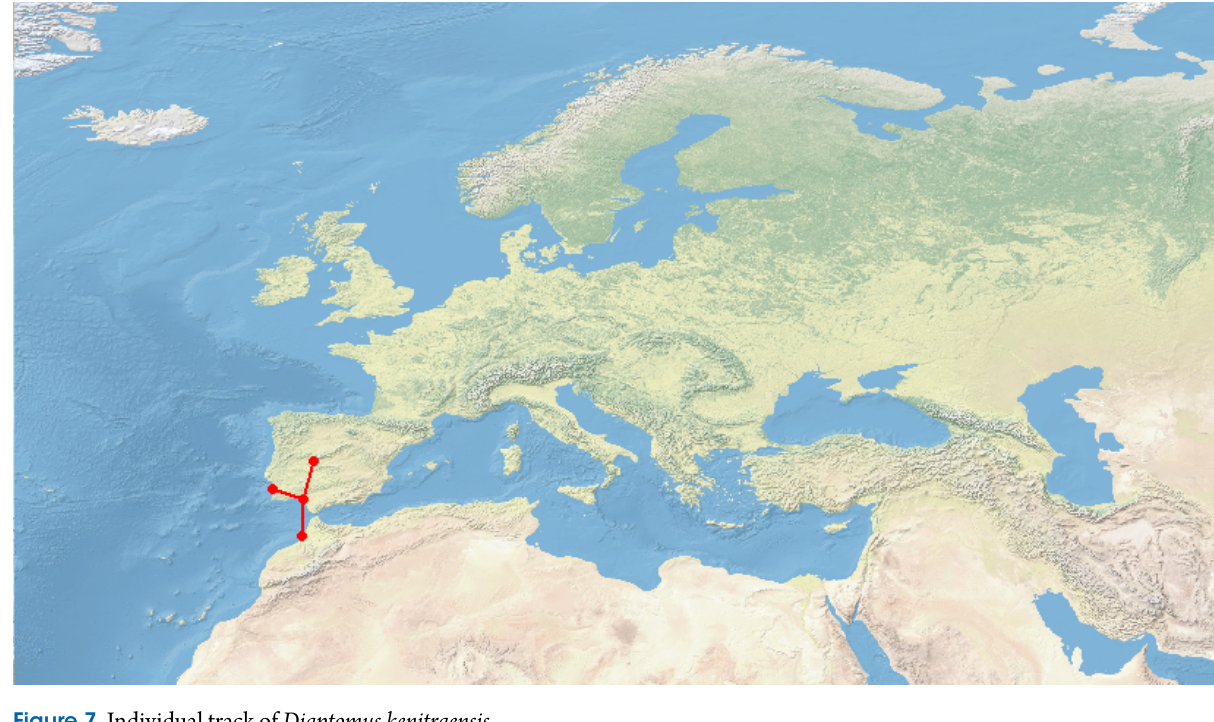
Figure 7. Individual track of Diaptomus